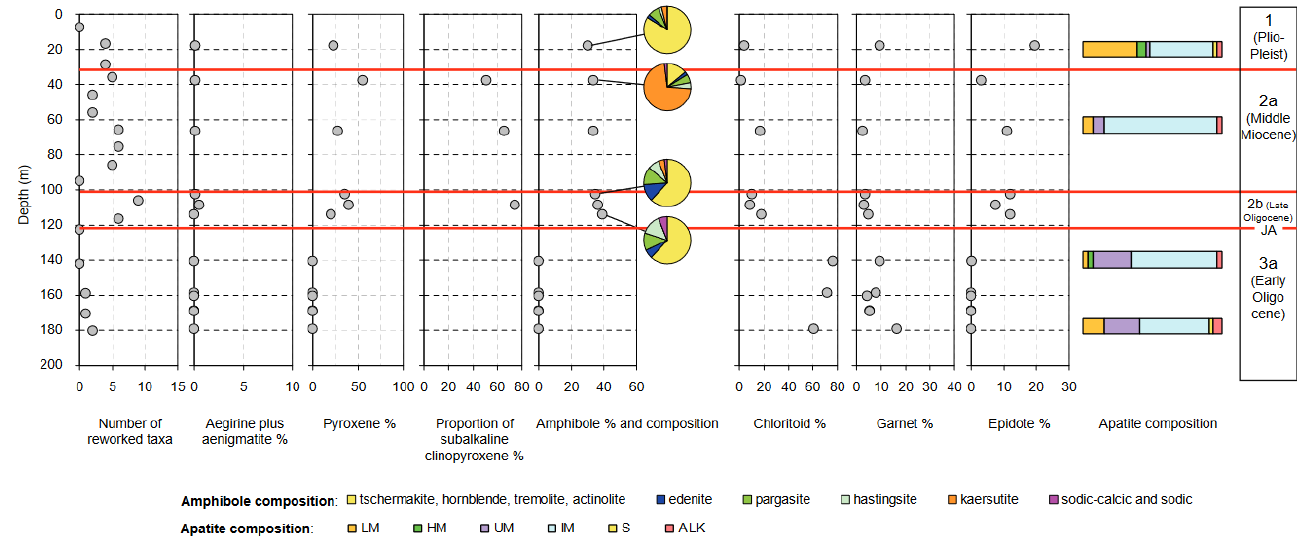
Figure 5. Variations in heavy mineral provenance character and reworked taxa at Deep Sea Drilling Project Site 346. LM = low and medium grade metamorphic and metasomatic, HM = high grade metamorphic, partial melts, leucosomes, UM = ultramafic igneous, IM = mafic igneous including mafic I-type granitoids, S = felsic igneous including S-type and felsic I-type granitoids, ALK = alkaline igneous.